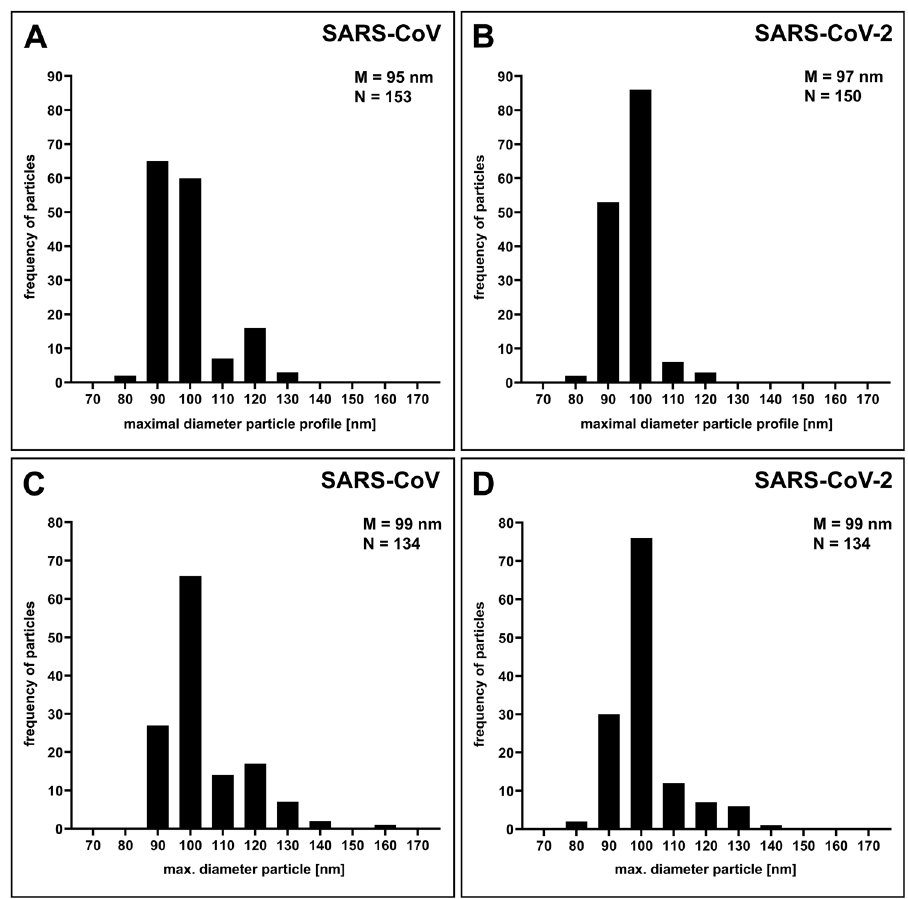
Figure 3. Particle size distribution of SARS-CoV and SARS-CoV-2. ( A , B) Histograms of maximal particle profile diameter without spikes in ultrathin (65 nm) sections (datasets 01 and 02; Table 1). ( C, D ) Histograms of maximal particle profile diameter without spikes in electron tomograms of thin (150–180 nm) sections (datasets 04 and 05; Table 1). Particles were measured at their thickest diameter (see Fig. 4 and Methods section). M = median; N = number of measured